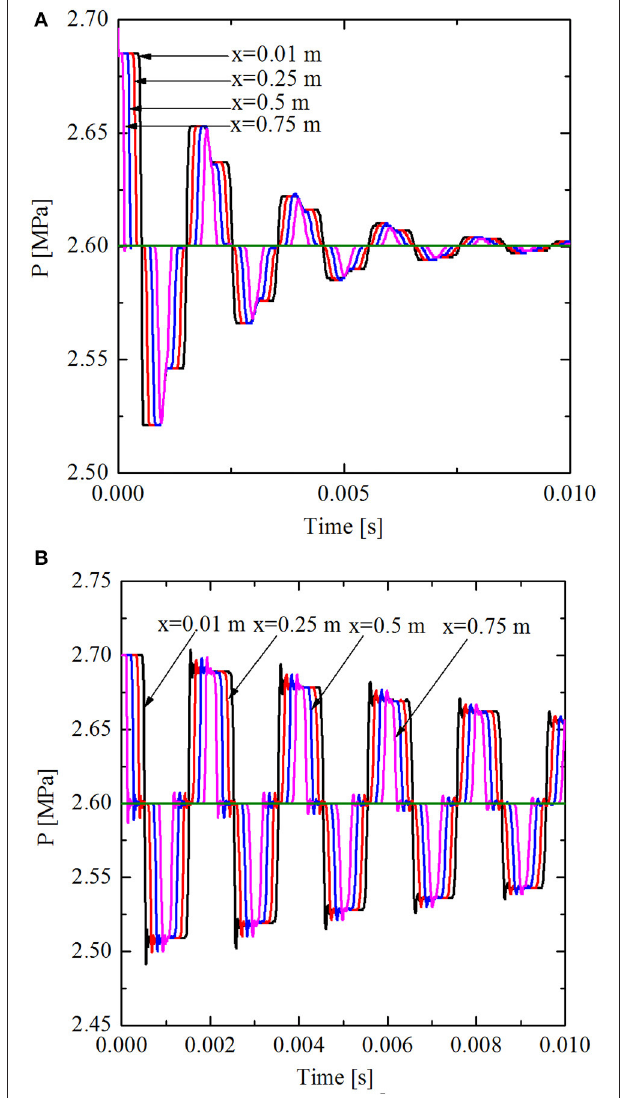
FIGURE 4 | Pressure responses of the nearly-implicit method under different time steps. (A) 1 t = 10 − 6 s. (B) 1 t = 10 − 7 s.